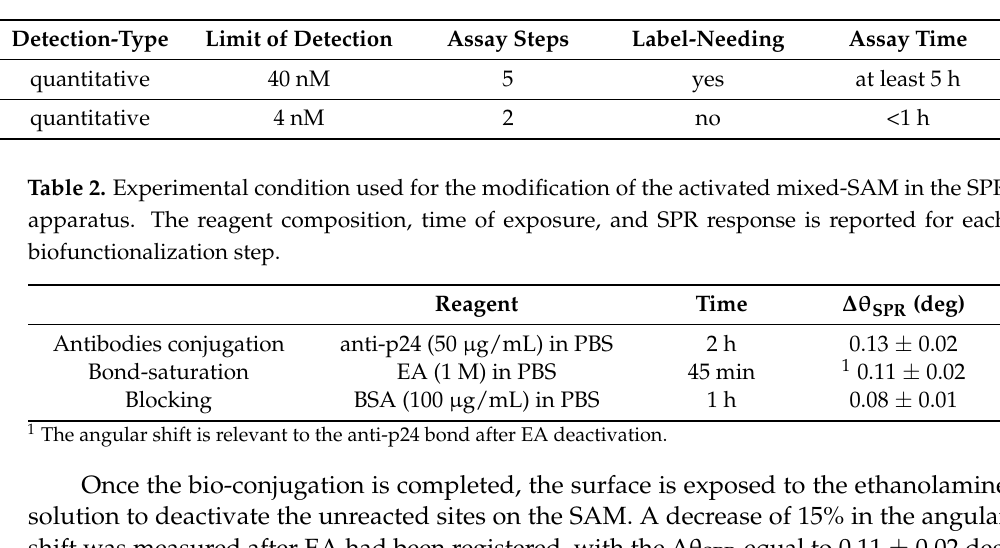
Table 1. Differences in performance between multi-parameter SPR and ELISA gold standard for the detection of HIV-1 p24 proteins.